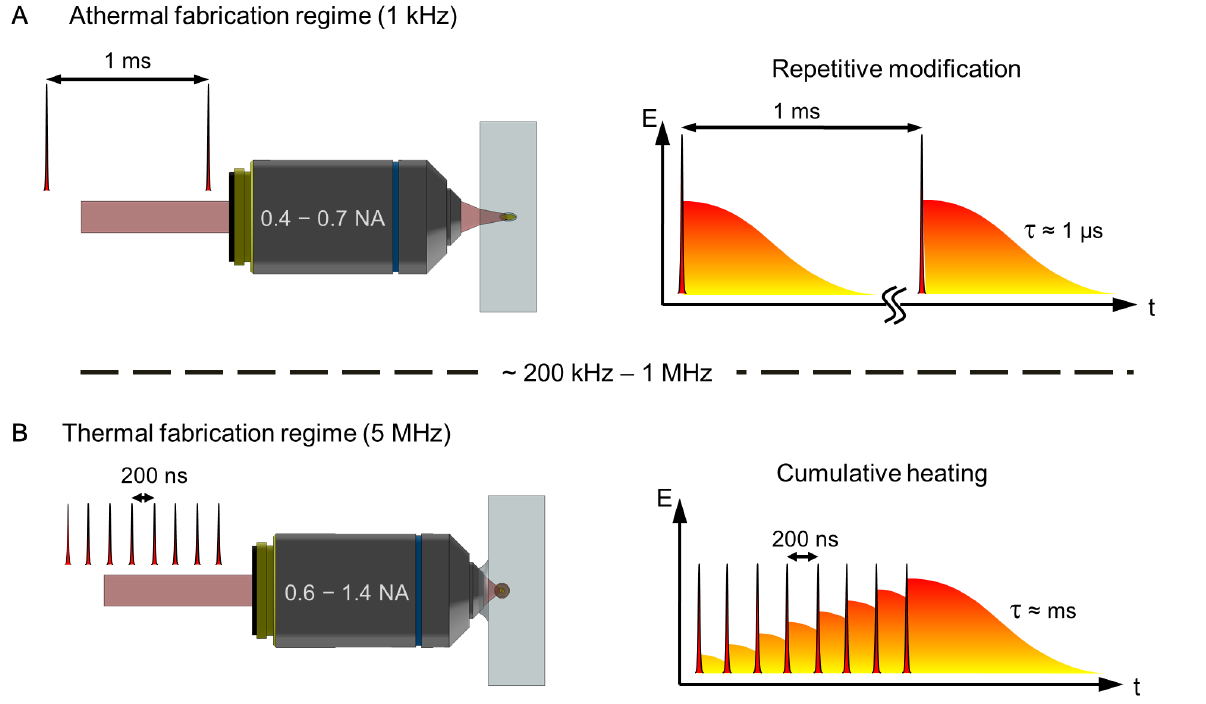
Figure 3: (A) Athermal fabrication using a low numerical aperture (NA), long working distance microscope objective. The pulse period which is significantly longer than the thermal diffusion time, results in a repetitive, pulse-by-pulse modification of the material, because there is suflcient time between pulses for the heat to diffuse out before the next pulse arrives. (B) Thermal fabrication regime using a high-NA oil immersion objective with a short working distance. The high laser repetition rate results in cumulative heating, causing melting of the material.